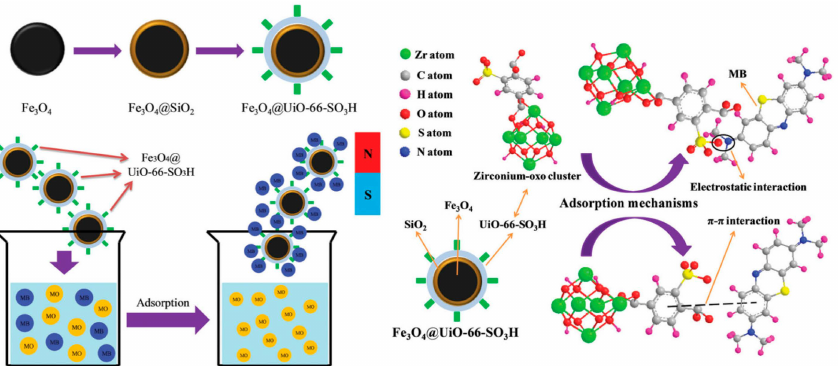
Figure 8. Schematic diagram of selective adsorption of MB by Fe 3 O 4 @UiO-66-SO 3 H and correspond- ing adsorption mechanism. Reprinted with permission from Ref. [104]. Copyright 2019, Royal Society of Chemistry.